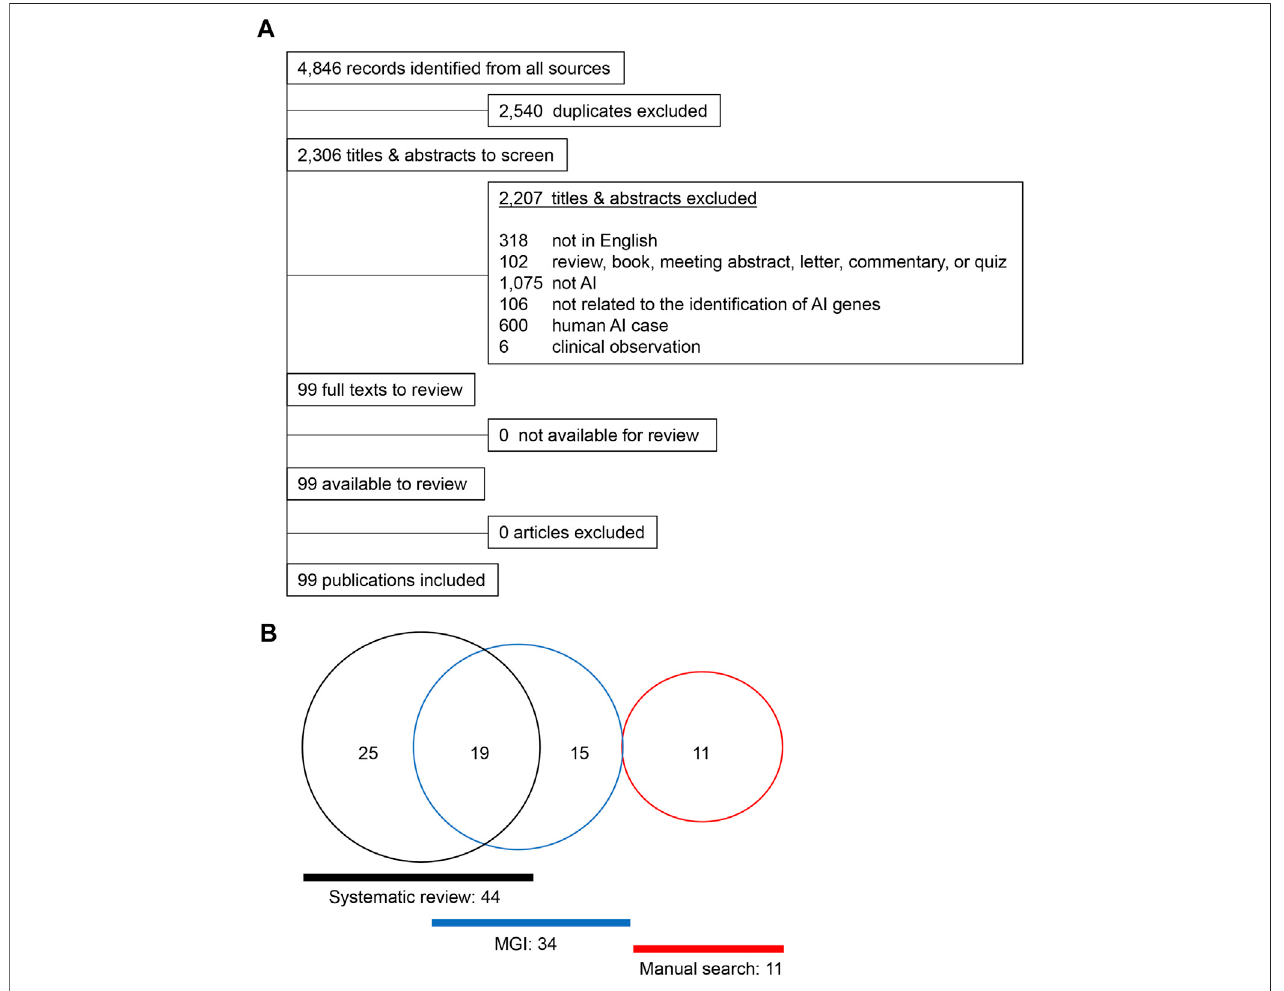
FIGURE1| Summary oftheliteraturesearch. (A) PRISMA fl owchartforamelogenesisimperfectaarticles indifferentspeciesotherthan humans. (B) Venndiagram for the amelogenesis imperfecta study.